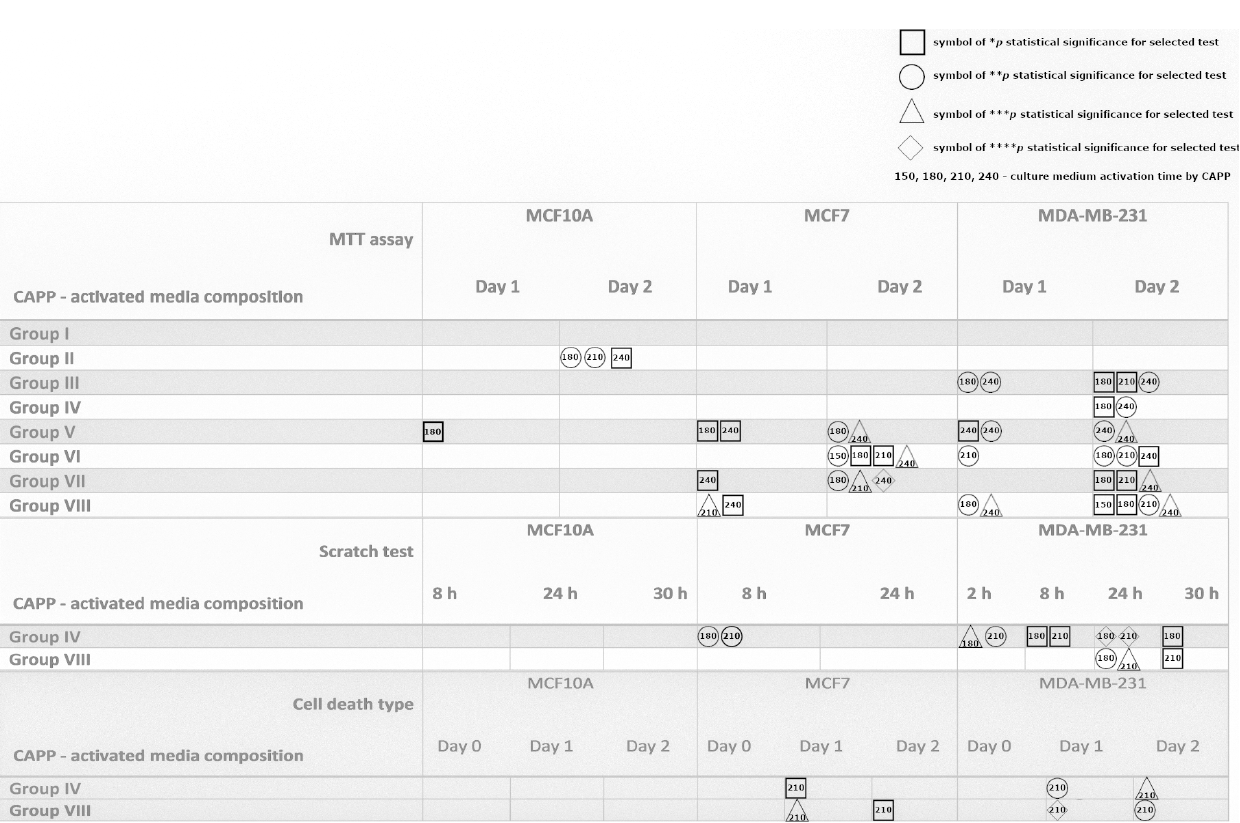
Figure 5. A graphical summary of the biological results successively obtained from the MTT assay (Figures 1 and 2), the scratch test (Figure 3), and the cell death type appearance (Figure 4). □ —the * p statistical significance for the selected test; —the ** p statistical significance for the selected test; ∆ —the *** p statistical significance for the selected test; ◊ —the **** p statistical significance for the selected test in all the investigated CAPP-activated media compositions. The numbers given inside the symbols (150, 180, 210, and 240 s) describe the CAPP-activation times of the culture